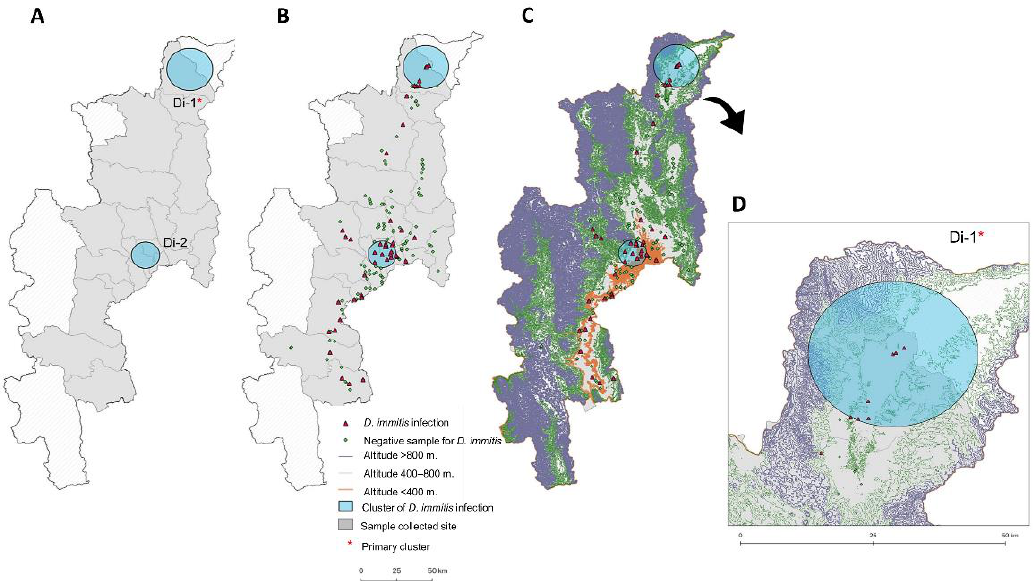
Figure 5. Geographic spatial clusters of D. immitis infection obtained using the Bernoulli scan statistic model. ( A ). the distribution of four clusters of D. immitis infection; ( B ). the distribution of D. immitis cases in each cluster; ( C ). the altitudinal distribution of D . immitis cases in each cluster; ( D ) . the distribution of D . immitis cases in the most likely cluster. Table 4. Geographic spatial clusters obtained by Bernoulli scan statistic model on canine filariasis in Chiang Mai, Thailand. Cluster